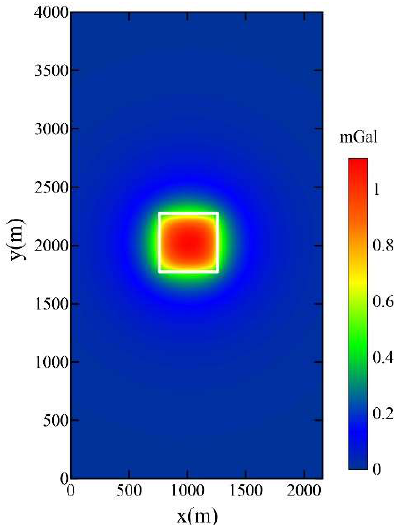
Figure 3. Contour map of the gravity anomaly for the model.